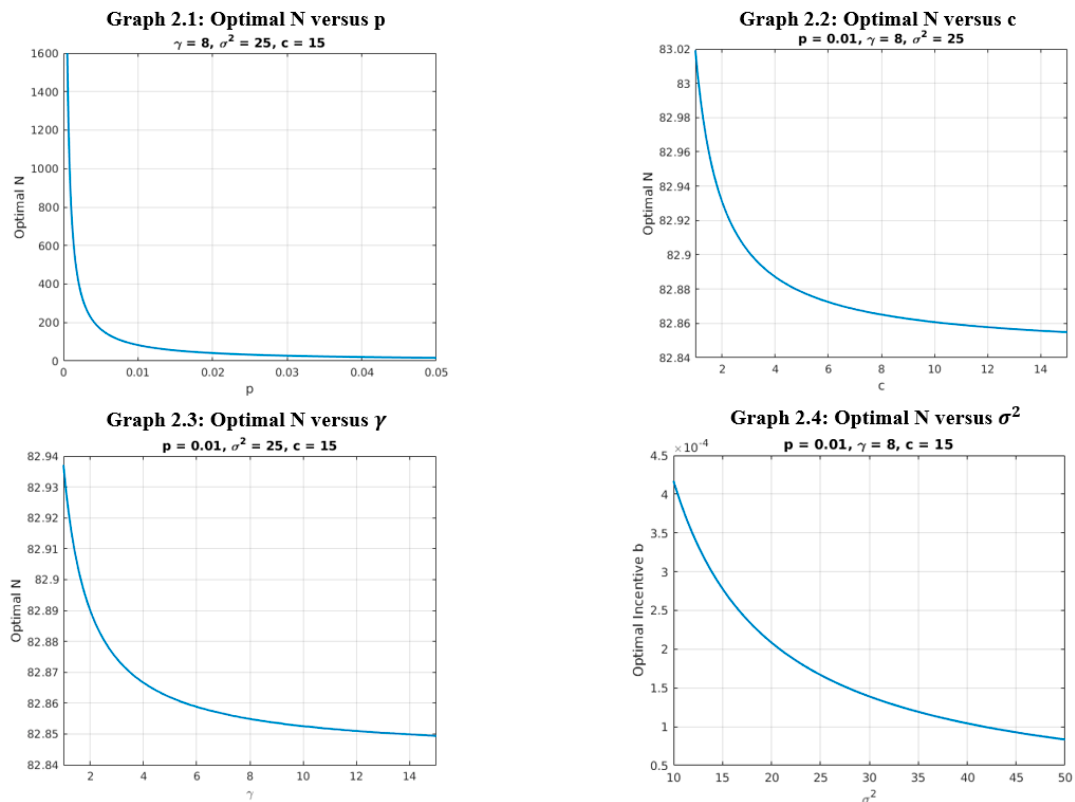
Figure 2. Comparative Static Analysis on the Optimal Number of Directorships.